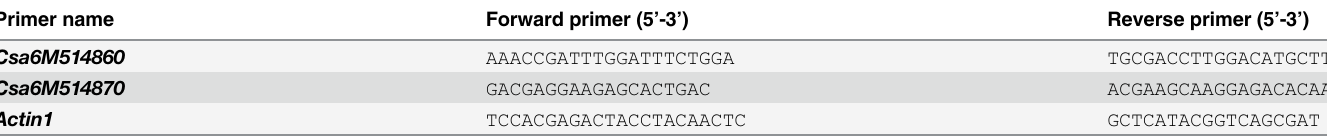
Table 3. The primer sequences of quantitative real-time